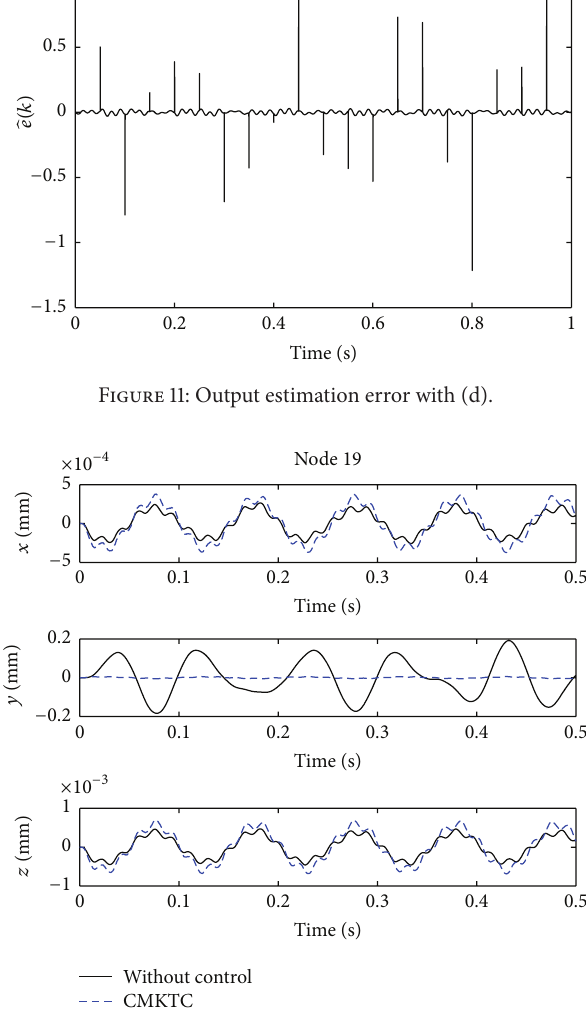
Figure 12: Displacement of node